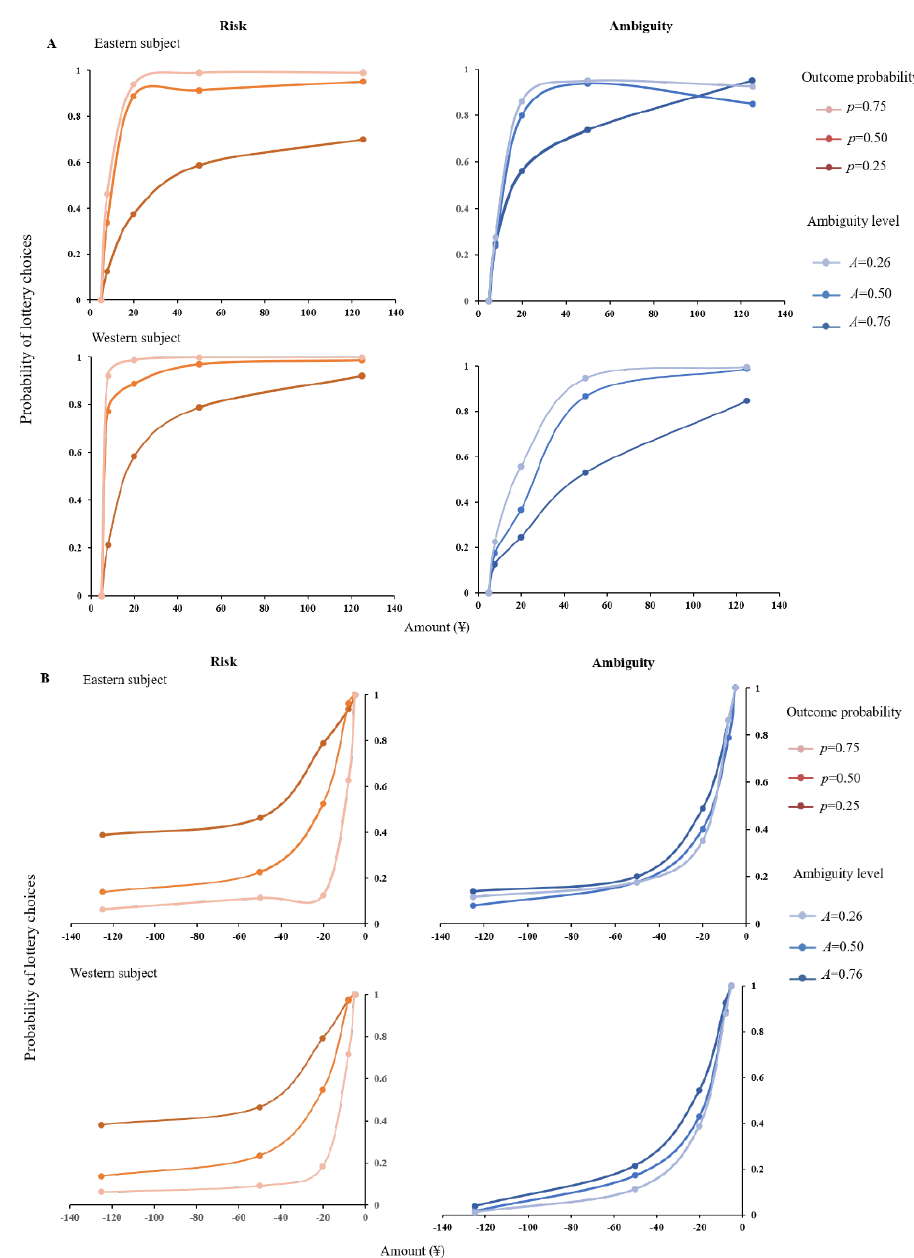
Figure 2. Subjects’ choice behaviors. The graphs represent the proportion of trials in which a subject chose the lottery over the certain amount, i.e., RMB 5 ( A ) or RMB − 5 ( B ), as a function of the given amount in risky ( Left ) and ambiguous ( Right ) tests. Points denote actual choice behaviors. Smooth lines are a result of fitting the choice data to the subjective theoretical model.